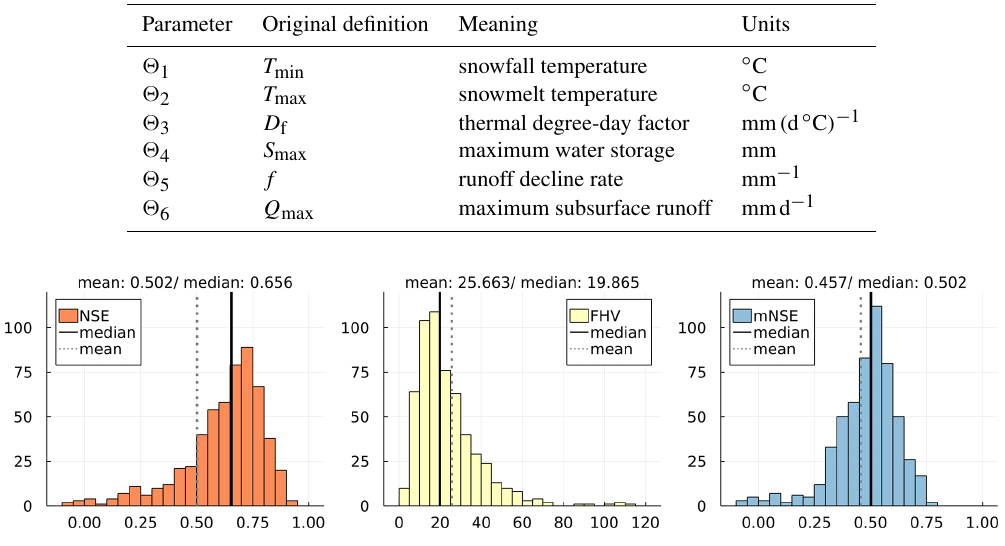
Figure A1. Histograms of NSE (orange; optimal value: 1), FHV (yellow; optimal value: 0) and mNSE (blue; optimal value: 1) for the SAC-SMA model over 569